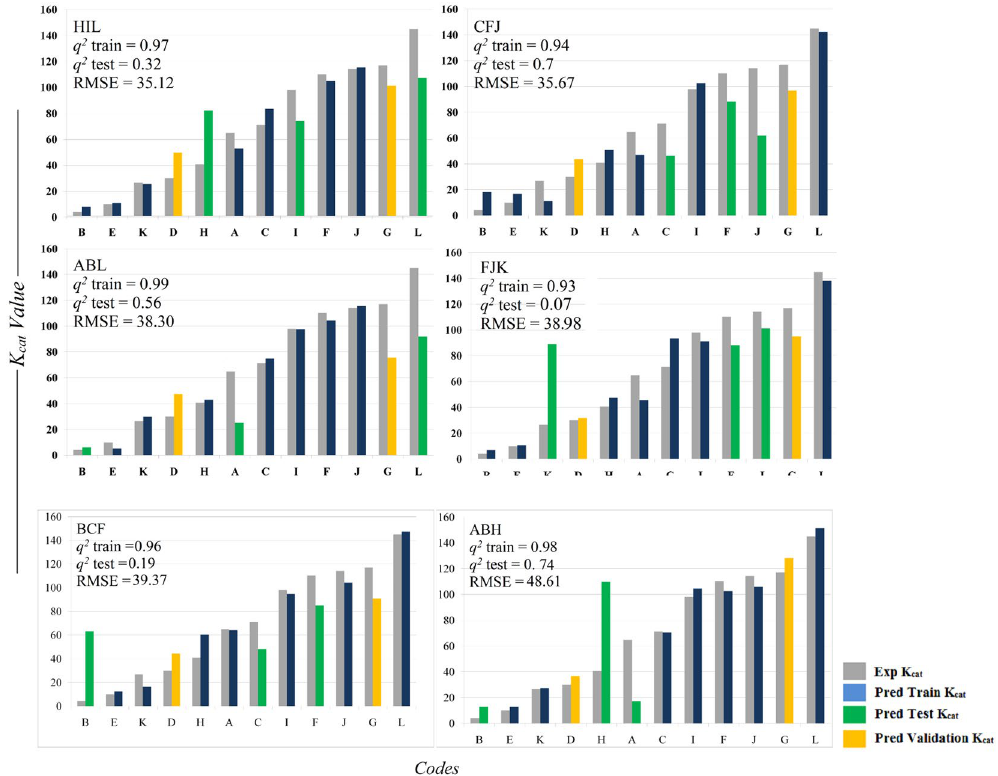
Figure 3. Analysis of the predicted activity values generated using PLS models derived from 6188 IEDs chosen based on the r value > 0.45. Graph shows the experimental vs. predicted activity values; training sets containing 7 codes (blue), test sets containing 3 codes (green); external validation set containing 2 codes (orange) and the respective experimental values (grey). The models sorted based on the least RMSD values of the training and the test set were used to predict the activity of the validation set (Table S6). The predicted K cat values were very much closer to the experimental values.